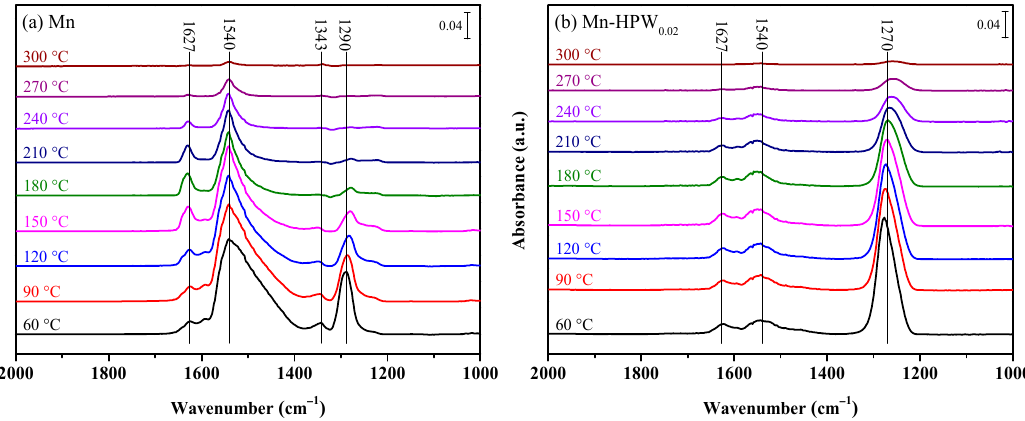
Figure 11. DRIFT spectra of NO x -derived species on Mn ( a ) and Mn-HPW 0.02 ( b ) obtained by subtracting the corresponding background spectra. The catalysts were pretreated with 500 ppm NO + 5% O 2 for 60 min and then purging by N 2 for 30 min at 30 °C.